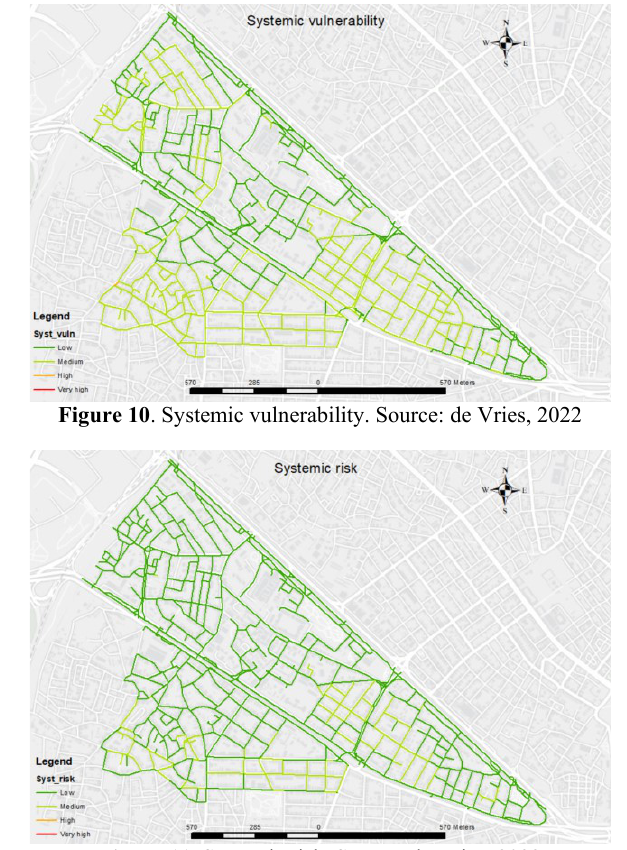
Figure 11 . Systemic risk. Source: de Vries, 2022